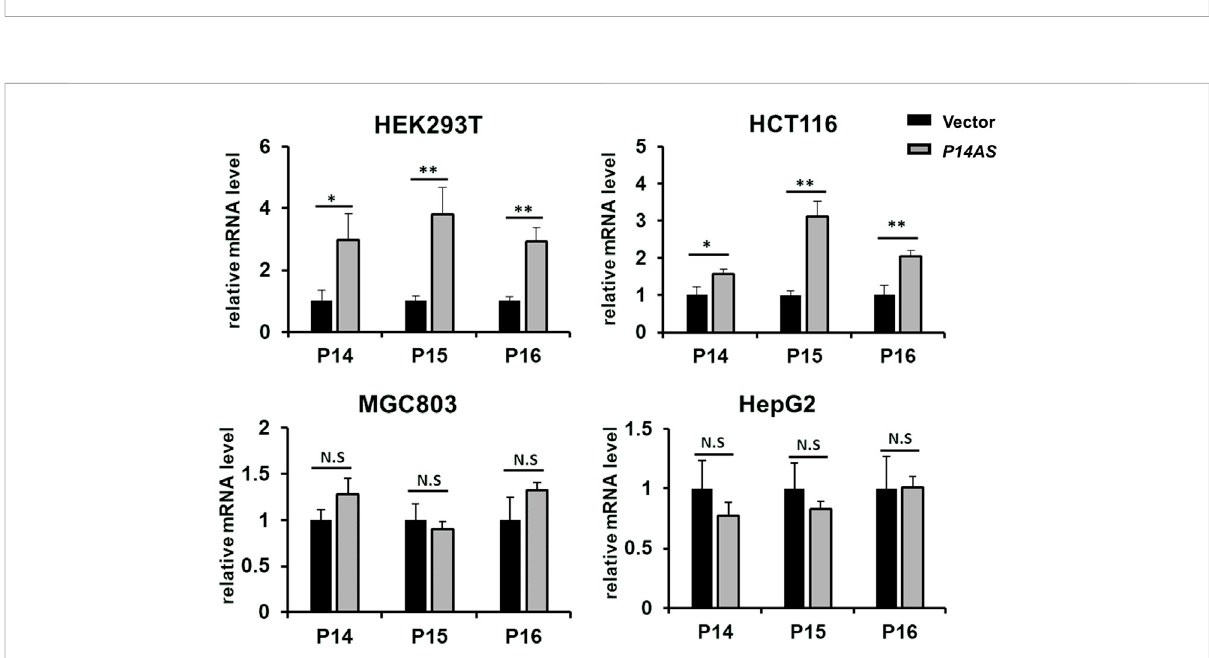
FIGURE 2 Effect of transient P14AS overexpression on the levels of P14 ARF , P16 INK4A and P15 INK4B expression in qTR-PCR analyses.